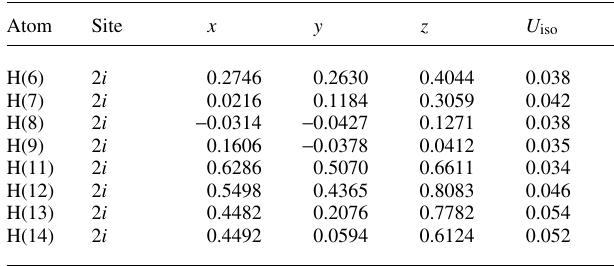
Table 2. Atomic coordinates and displacement parameters (in Å 2 )